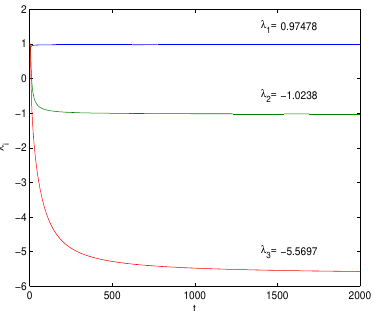
Figure 12. Lyapunov exponents of system (4) with parameters given in (18) and h = 0.05.